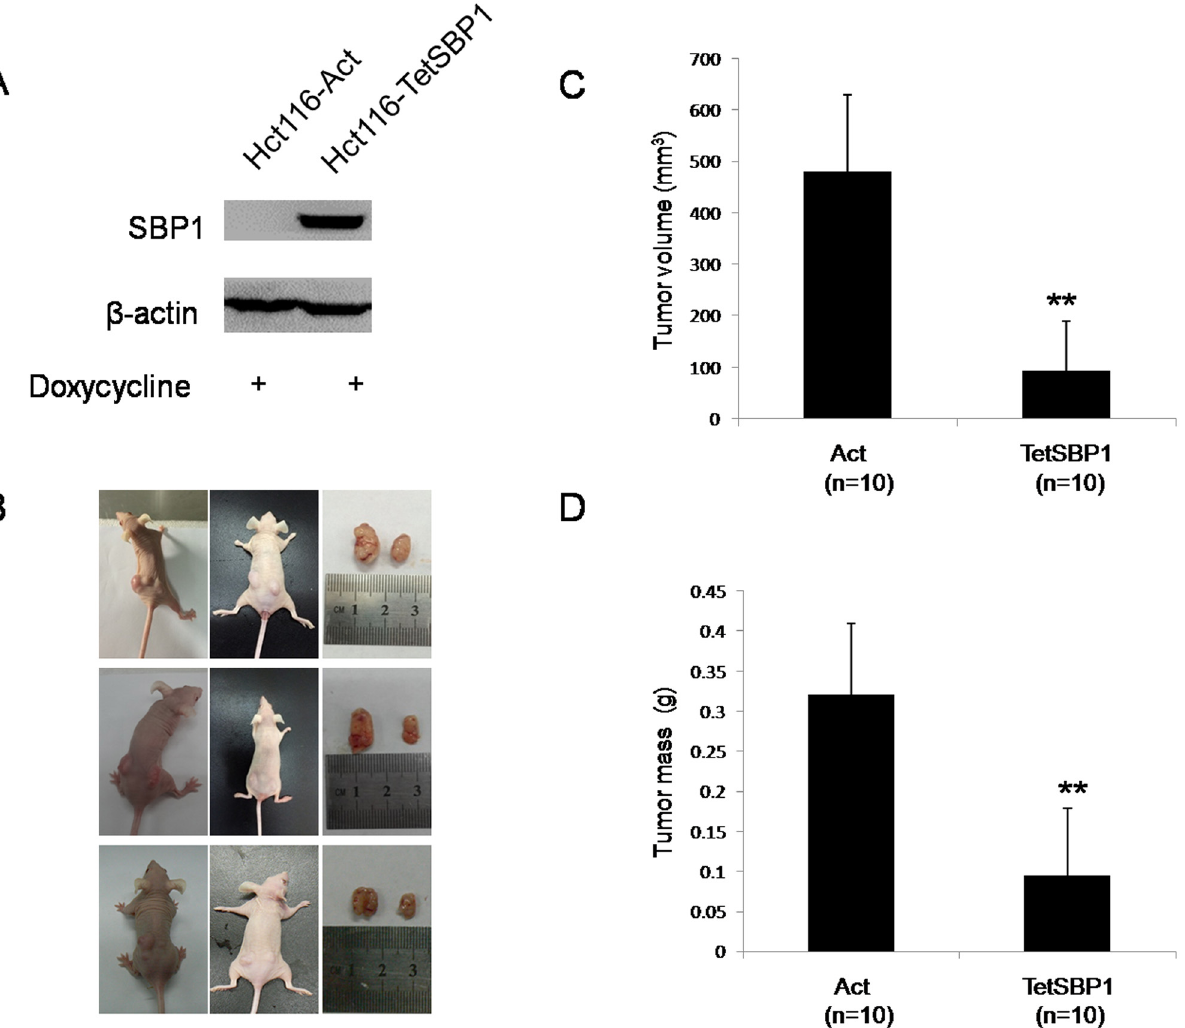
Fig 1. SBP1 induction in nude mice inhibited tumor growth of xenografts. (A) SBP1 induced by doxycycline in HCT116-TetSBP1 cells were validated by immunoblot analysis. (B) Photographs illustrate representative tumors in xenografts with SBP1 induction (TetSBP1, right) compared to tumors without SBP1 induction (Act, left). 10 mice in total. (C-D) SBP1 induction results in a decline of tumor volume and weight. Results were analyzed with Student ’ s t-test and shown as mean ± SD. ** P <